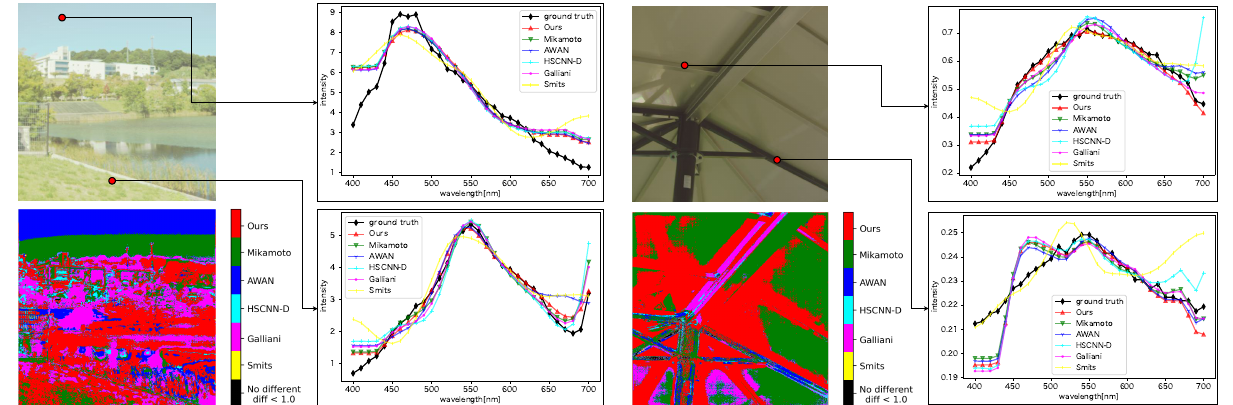
Figure 10. Qualitative evaluation of each method on the ME HS dataset. For each sub-figure, the upper left is the input image, the lower left shows the most accurate method for each pixel based on the evaluation metric SAM, and the upper right and lower right plot the spectral distributions for the selected pixels. The evaluation of each method is based on the best result among the cases with and without preprocessing.